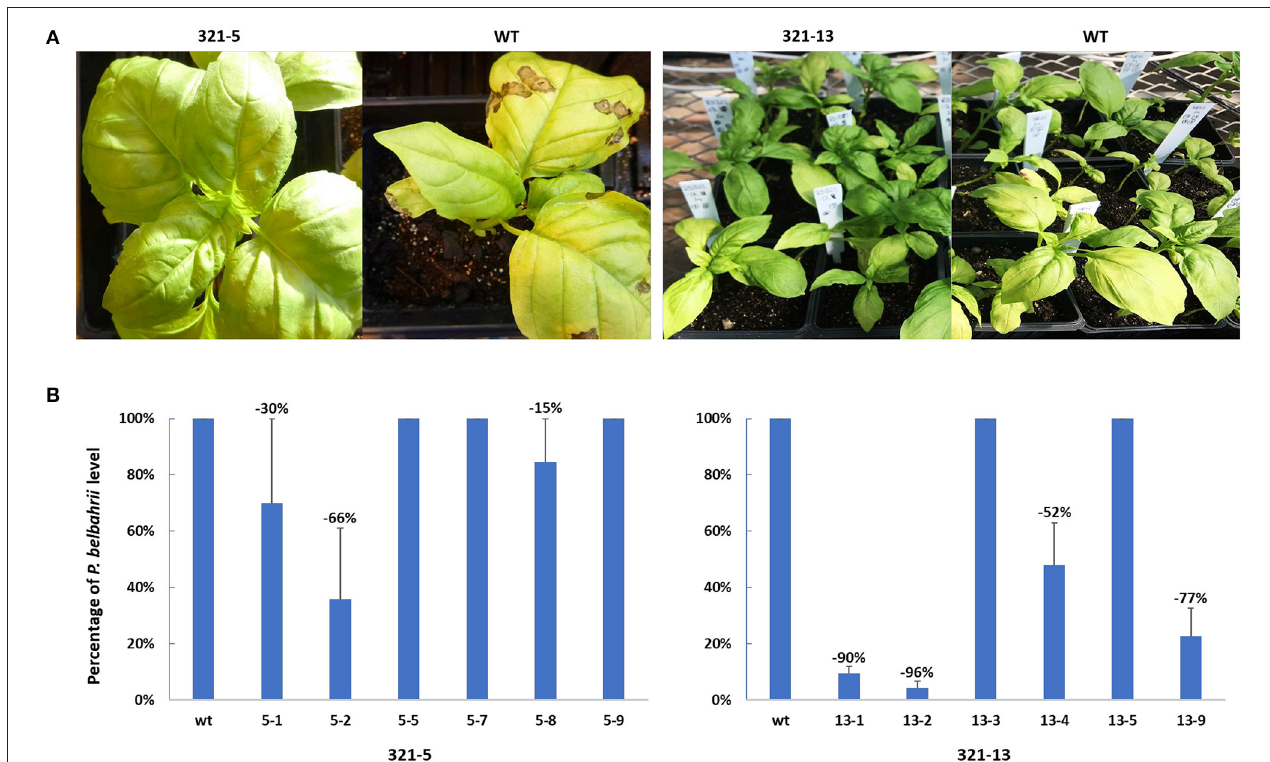
FIGURE 4 | (A) DM resistance in gene edited plants, 321-5 and 321-13. T 1 and WT plants were inoculated in separate batches. Disease symptoms were recorded 15 days after P. belbahrii inoculation. (B) qPCR analysis of P. belbahrii levels in planta for individual T 1 plants, sampled in triplicate, 5 days post inoculation. P. belbahrii ITS2-specific primers as well as basil β -tubulin gene-specific primers were used to determine 2 − 11 Ct relative levels of the pathogen. Pathogen reduction in T 1 plants was calculated as a percentage compared to WT plants (assessed as 100% each time) and averaged from three separate qPCR assays, with standard deviations